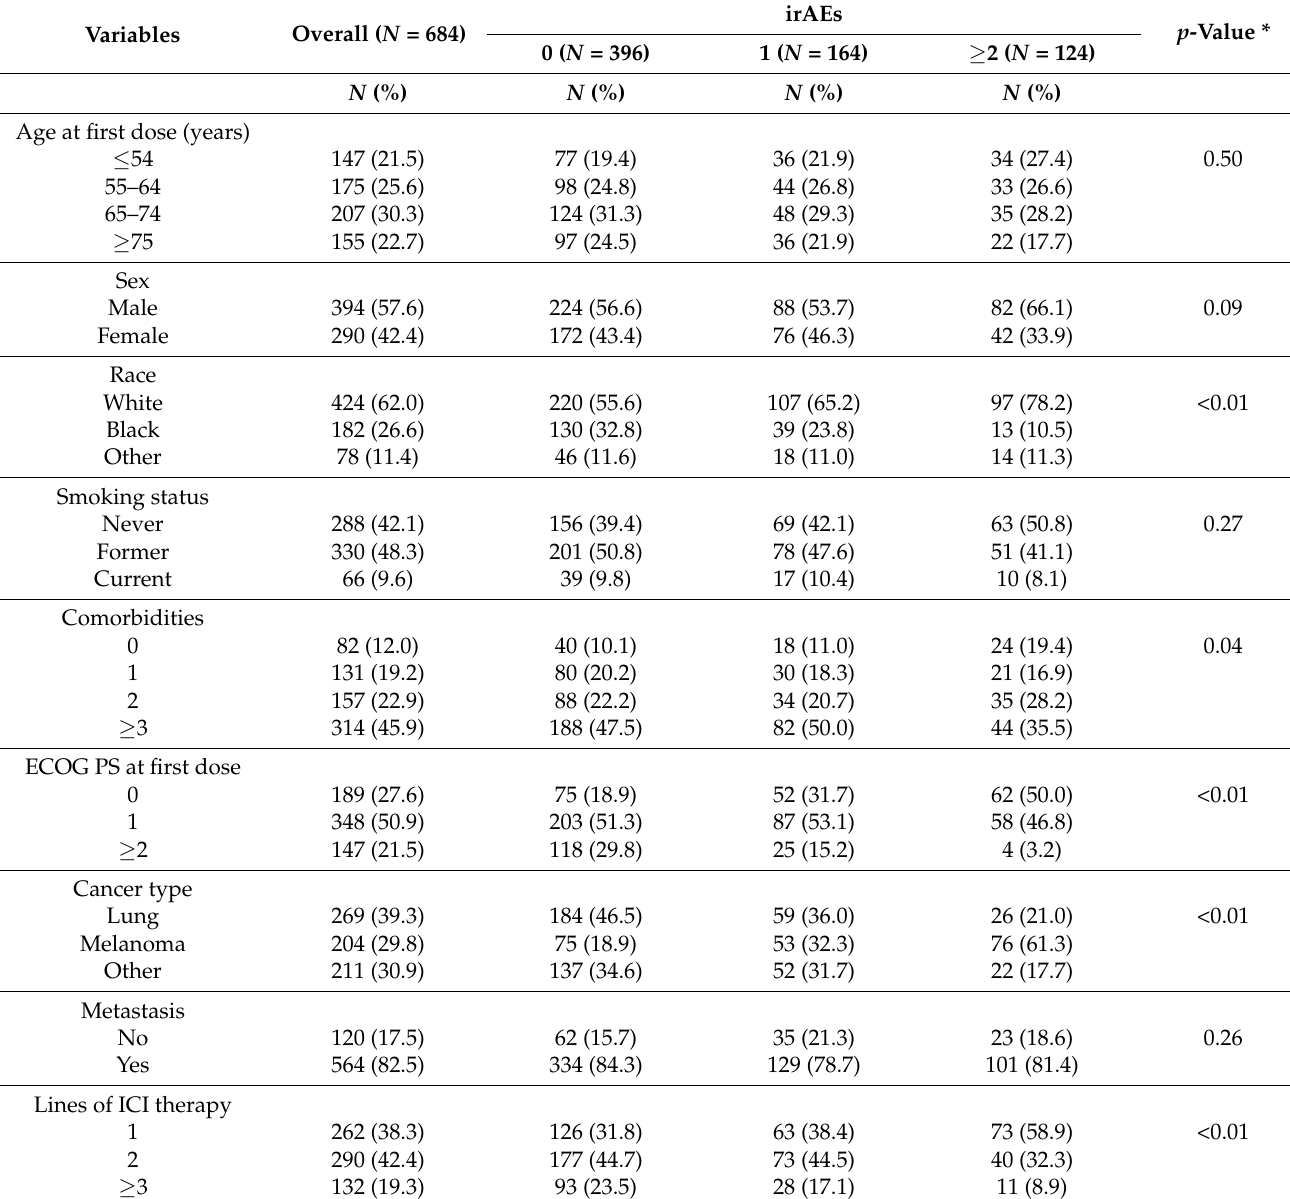
Table 1. Summary of study